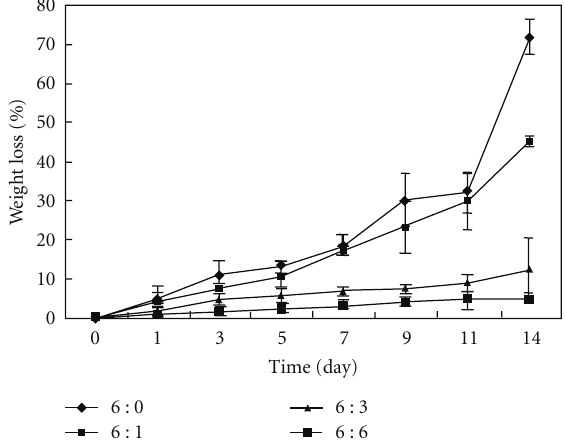
Figure 4: Degradation behavior of porous collagen sca ff olds integrated with PLLA